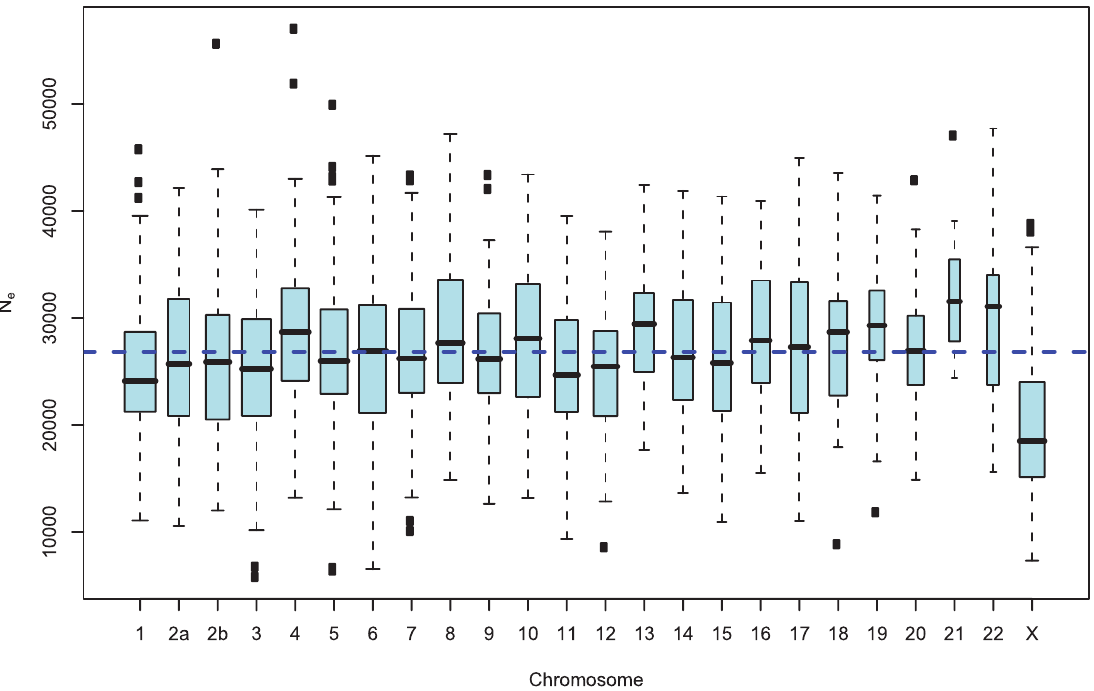
Figure 10. Distribution of effective population size estimates for each chromosome. The box plot shows the distribution of the estimated ancestral effective population on each chromosome. The dashed line shows the genome-wide average. In general, the estimates are reasonably consistent between the chromosomes, with one exception being chromosome 21. Chromosome X is within the expected range of 3 = 4 of the autosomal